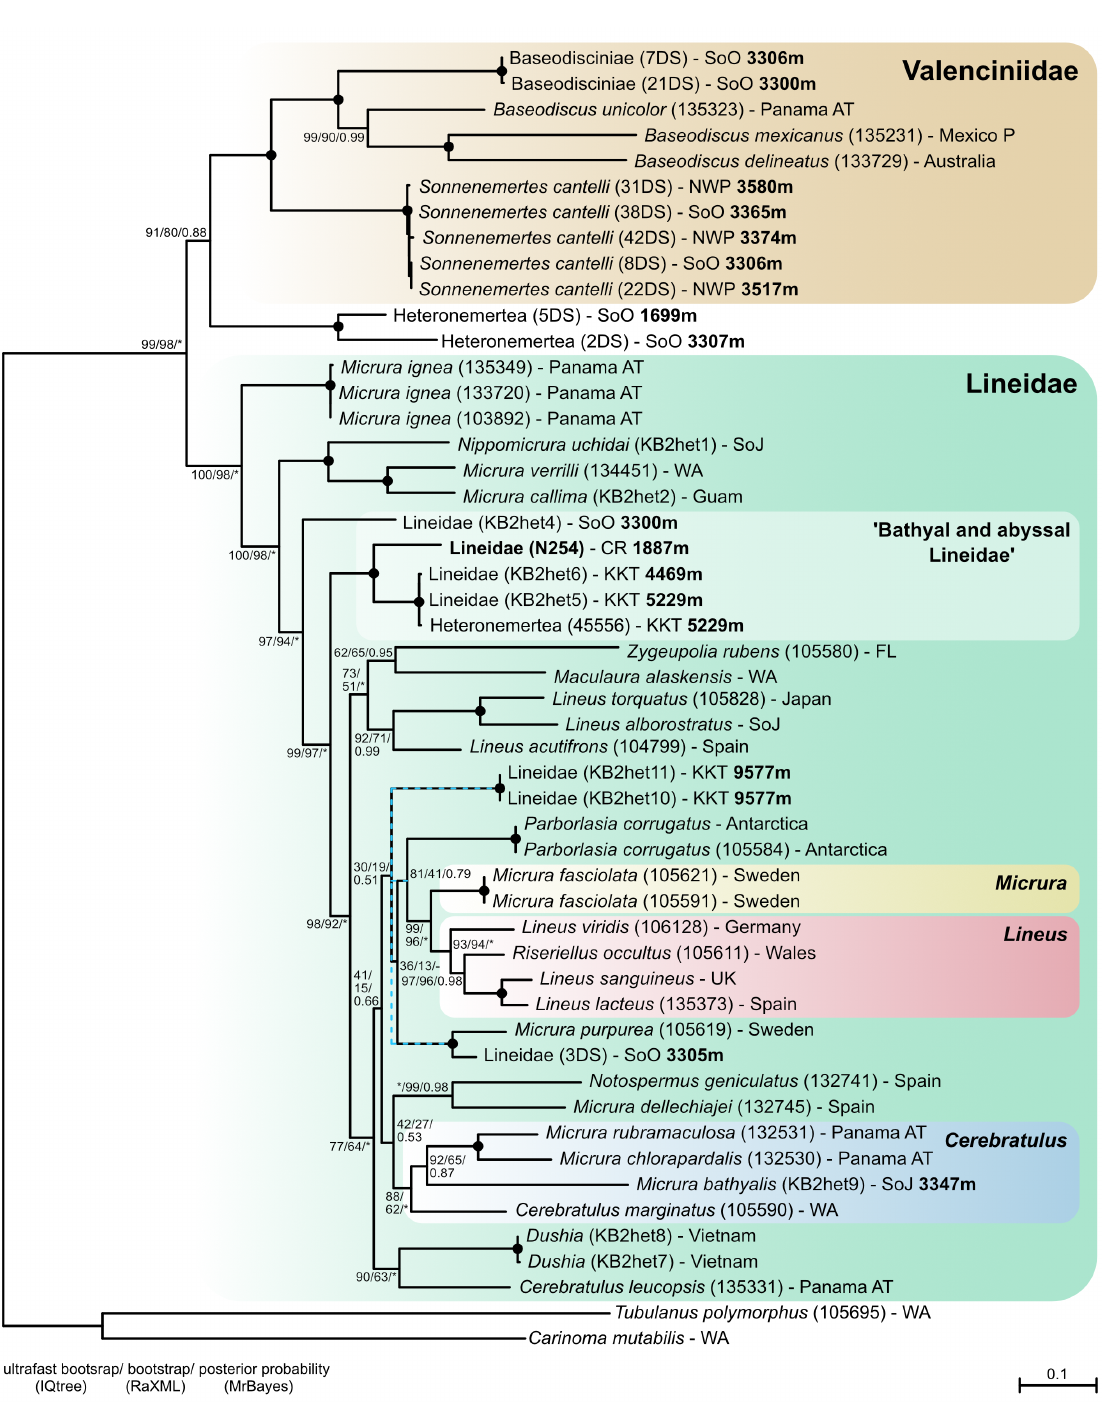
Fig. 5. Maximum likelihood (ML) tree for the heteronemertean supermatrix based on the concatenated four gene dataset (16S, COI, 18S, H3). Numbers beside nodes indicate support values. Black circles indicate nodal support of 100/100/1.0; asterisks indicate nodal support of either 100/ or /1.0. Alternative branches found in the BI analysis are given as blue dotted lines. Tubulanus polymorphus Renier, 1804 and Carinoma mutabilis Griffin, 1898 were used for outgroup rooting. The specimen found at the Costa Rica margin is given in bold. Specimen-ID, sampling locality, and depth (for deep-sea species) are